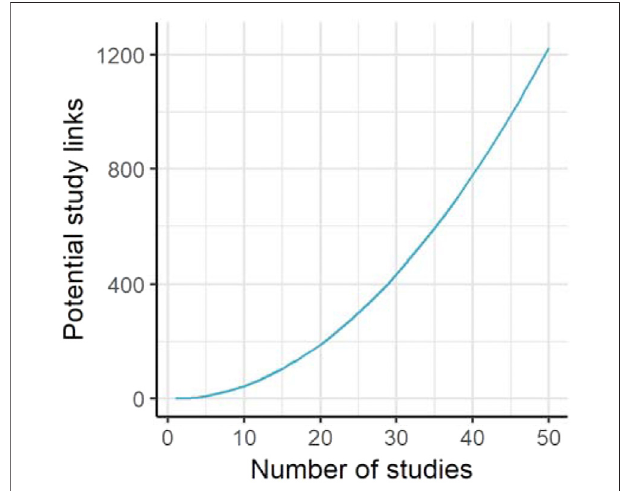
FIGURE 4 | The number of potential links between individual studies as the number of studies increases within an integrated program. Potential study links are calculated as Ns * (Ns - 1)/2 where Ns is the number of studies; If a program consists of 10 component studies, there are theoretically 45 possiblelinkagesbetweenthestudies,eachofwhichneedstobeconsidered. If there are 15 studies, the number of potential linkages increases to